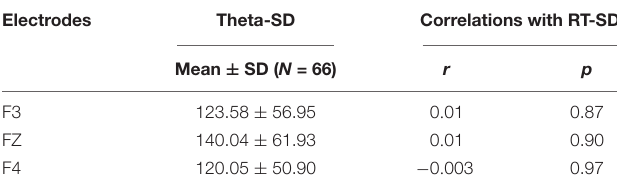
TABLE 2 | RT-ALFF in each frequency band for the task performance. TABLE 3 | Theta-SD and its correlations (Kendall rank correlation) with RT-SD.